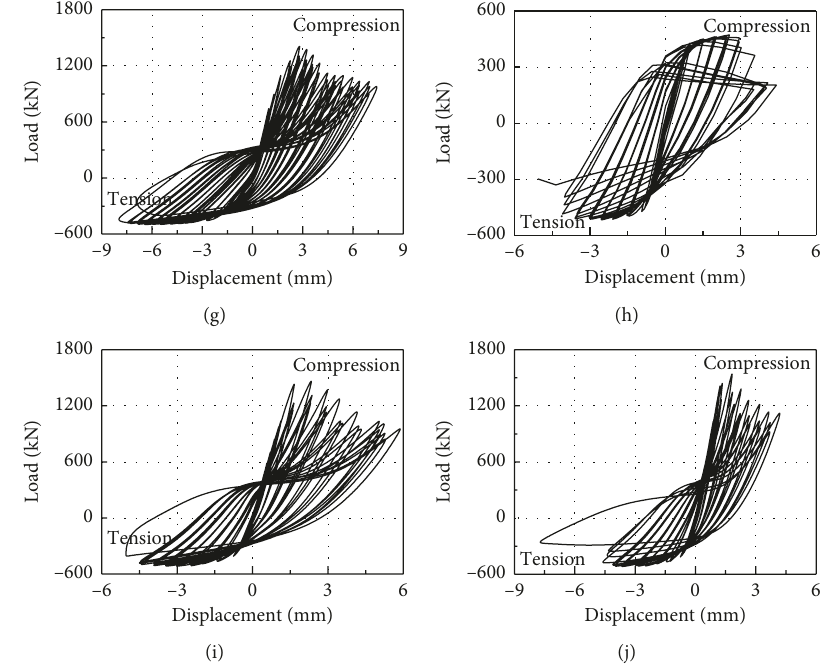
Figure 6: Cyclic axial load versus longitudinal deformation curves for specimens. (a) HST-1; (b) CFST-2; (c) CFST-3; (d) CFST-4; (e) CFST-5; (f) CFST-6; (g) CFST-7; (h) HST-8; (i) CFST-9; (j)